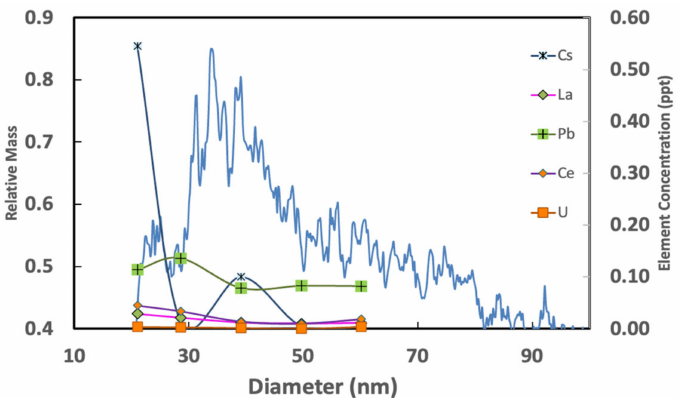
Figure 8. Size-dependent elemental distribution of trace elements, Cs, La, Pb, Y, Ce, and U in nanoparticles with hydrodynamic diameters d ≤ 60 nm, isolated from the bolter sample. The blue line shows the size distribution, measured by asymmetrical flow field-flow fractionation (AsFlFFF). Trace elements for the bolter sample by SdFFF were not measured.